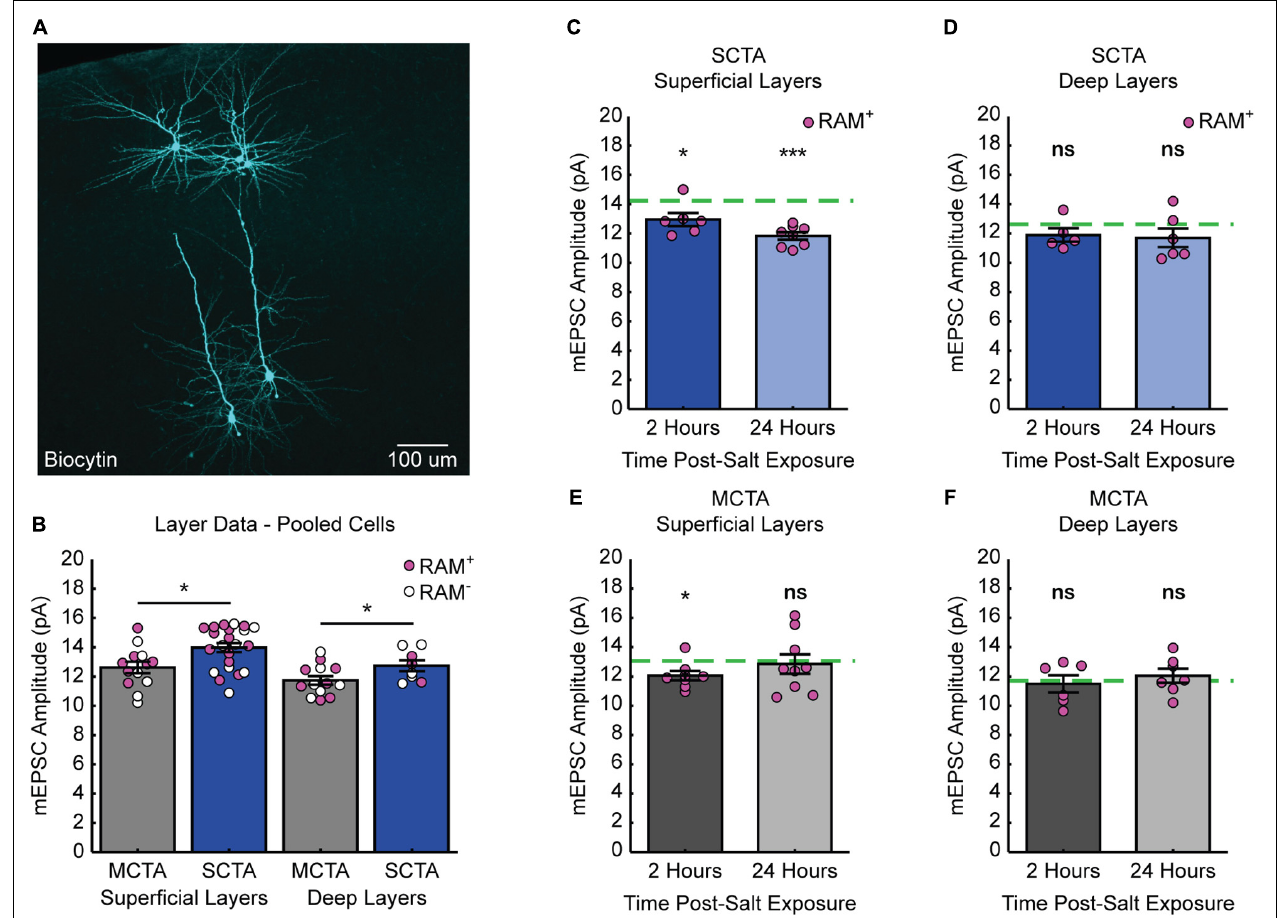
FIGURE 5 | Distinct layer processes govern the induction and reversal of generalization. (A) Biocytin fills (cyan) of cells recorded from the superficial and deep layers of gustatory cortex. (B) Cell-average mEPSC amplitudes of pooled RAM + and RAM − cells 3 days post-conditioning sorted by superficial and deep layers (superficial layers, two-sample t test, p = 0.0104; deep layers, two-sample t test, p = 0.0498). (C) SCTA cell-average mEPSC amplitudes of RAM + cells from superficial layers 2- and 24-h post-salt exposure. Green dashed line represents average mEPSC amplitude from RAM + cells from superficial layers in SCTA no-salt exposure conditions ( B ; one-sample t test against hypothesized mean, 2 h, p = 0.0355, 24 h, p = 2.7205e-05). (D) SCTA cell-average mEPSC amplitudes of RAM + cells from deep layers 2- and 24-h post-salt exposure. Green dashed line represents average mEPSC amplitude from RAM + cells from deep layers in SCTA no-salt exposure conditions ( B ; one-sample t test against hypothesized mean, 2 h, p = 0.1929, 24 h, p = 0.2087). (E) MCTA cell-average mEPSC amplitudes of RAM + cells from superficial layers 2- and 24-h post-salt exposure. Green dashed line represents average mEPSC amplitude from RAM + cells from superficial layers in MCTA no-salt exposure conditions ( B ; one-sample t test against hypothesized mean, 2 h, p = 0.0166, 24 h, p = 0.7606). (F) MCTA cell-average mEPSC amplitudes of RAM + cells from deep layers 2- and 24-h post-salt exposure. Green dashed line represents average mEPSC amplitude from RAM + cells from deep layers in MCTA no-salt exposure conditions ( B ; one-sample t test against hypothesized mean, 2 h, p = 0.7262, 24 h, p =